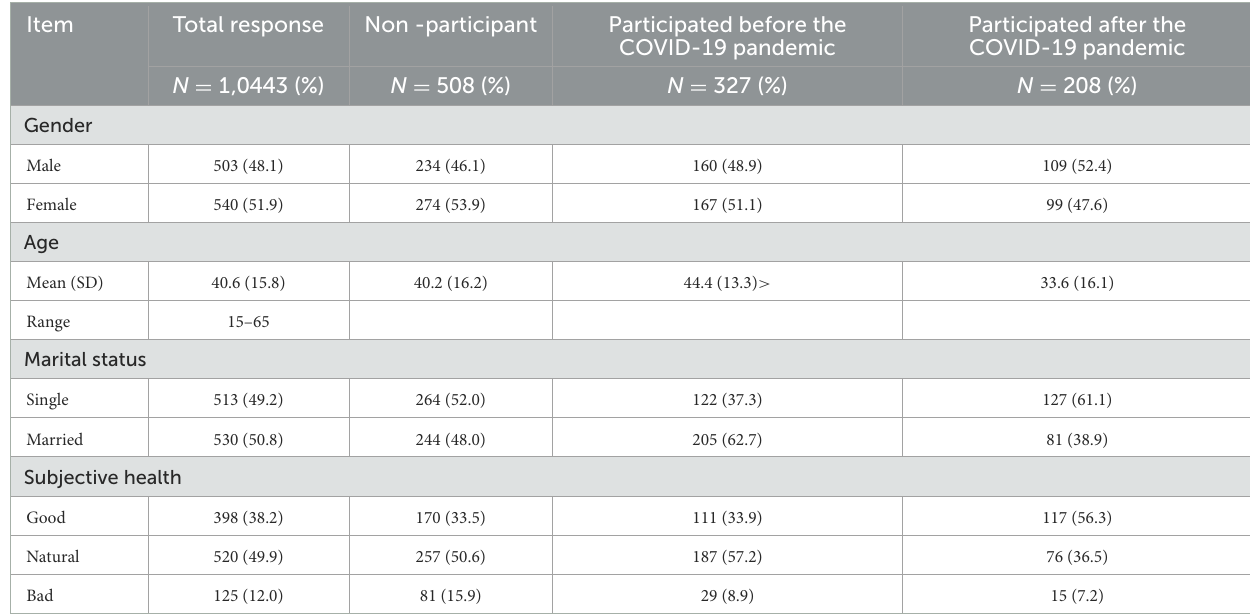
TABLE 1 Participant